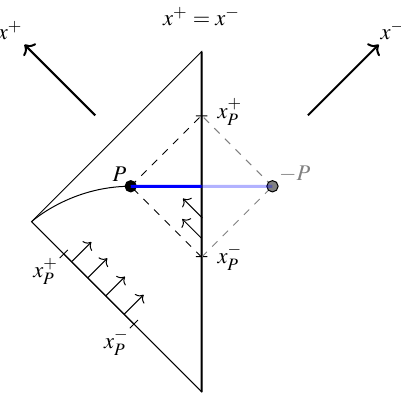
Figure 3 . To write down the expressions for S and H mod through the interval [ P , boundary x = 0], it is instructive to consider the doubled interval stretching from the point P to its mirror image P . The formula (4.2) counts the entanglement contribution from right-moving degrees of denoted (cid:0) freedom through the doubled interval, or the full entanglement through [ P , boundary x = 0]. We employ here the Penrose diagram representation of (cid:13)at space with future and past null in(cid:12)nity at 45 degree